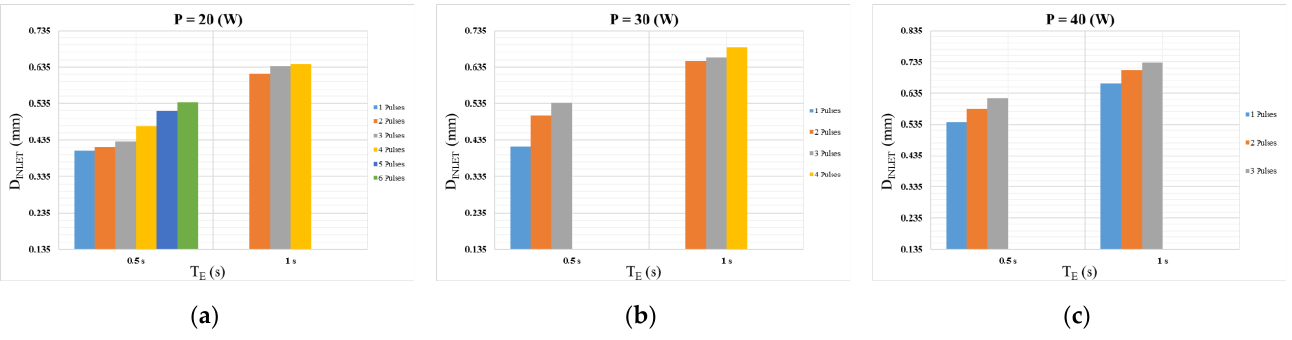
Figure 6. Influence of T E and N P on D INLET for 0.1 wt.% of CNPs and ( a ) P = 20 W, ( b ) P = 30 W and ( c ) P = 40 W.